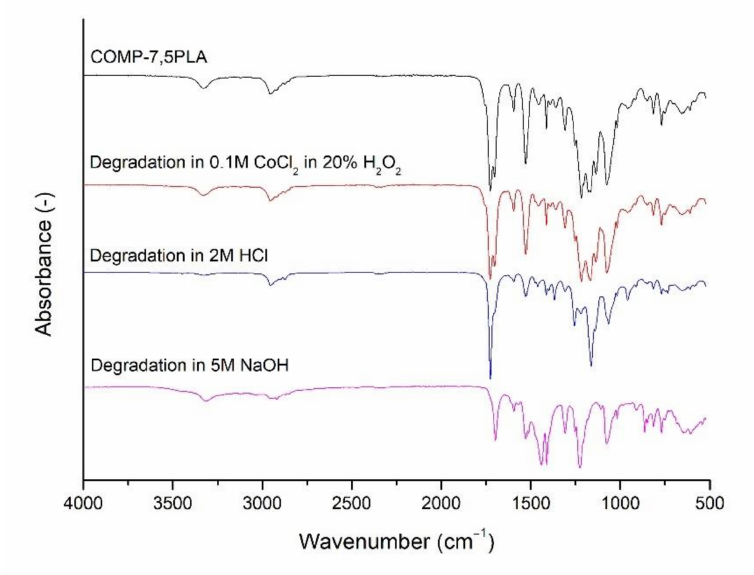
Figure 7. Comparative FTIR spectra of COMP-7,5 PLA sample before and after 15 days of degradation in selected media (0.1 M CoCl 2 in 20% H 2 O 2 , 2 M HCl and 5 M NaOH).